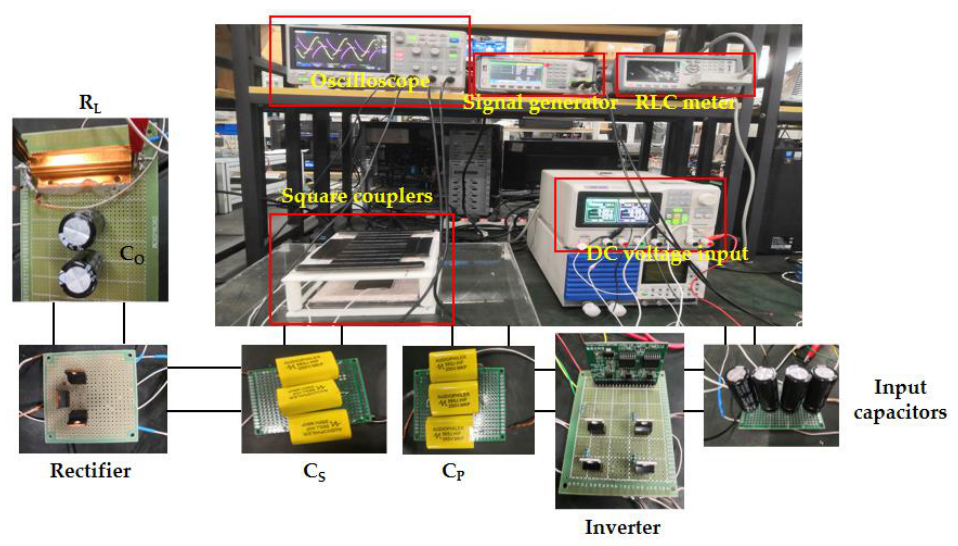
Figure 28. Experiment platform and connections.